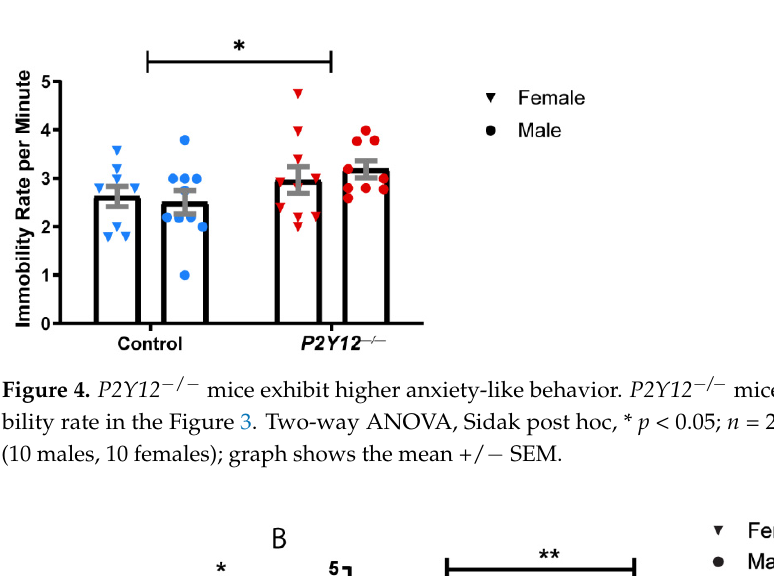
Figure 3. Behavioral testing of P2Y12 —/— mice: ( A ) timeline of behavioral testing; ( B ) P2Y12 —/— mice had a small increase in total distance traveled during the open field test; ( C ) there was no significant effect of genotype on the time spent in the center region of the open field test. ( B ),( C ): two-way ANOVA, Sidak post hoc, * p < 0.05; n = 20 mice per genotype (10 males, 10 females); graphs show the mean +/ − SEM.